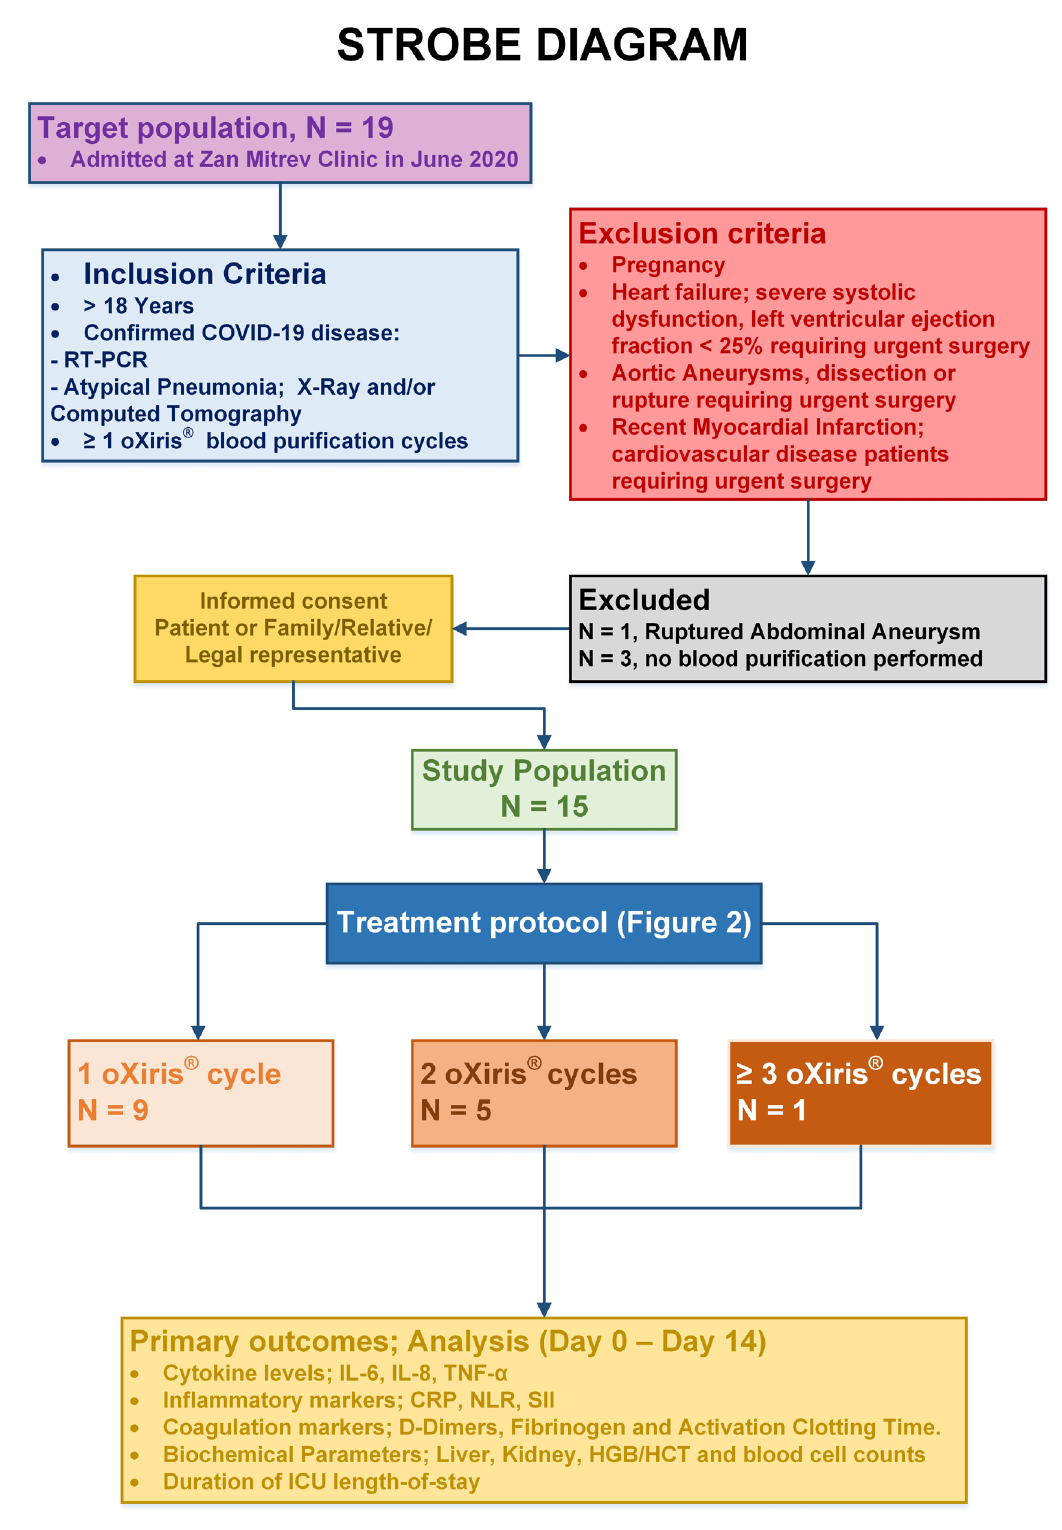
Fig. 1 - STrengthening the Reporting of OBservational studies in Epidemiology (STROBE) diagram. COVID-19=coronavirus disease 2019; CRP=C-reactive protein; HGB/HCT=hemoglobin/hematocrit; ICU=intensive care unit; IL=interleukin; NLR=neutrophil-to-lymphocyte ratio; RT- PCR=reverse transcription polymerase chain reaction; SII=systemic immune-inflammation index, thrombocyte*(neutrophil-to-lymphocyte); TNF-α=tumour necrosis factor